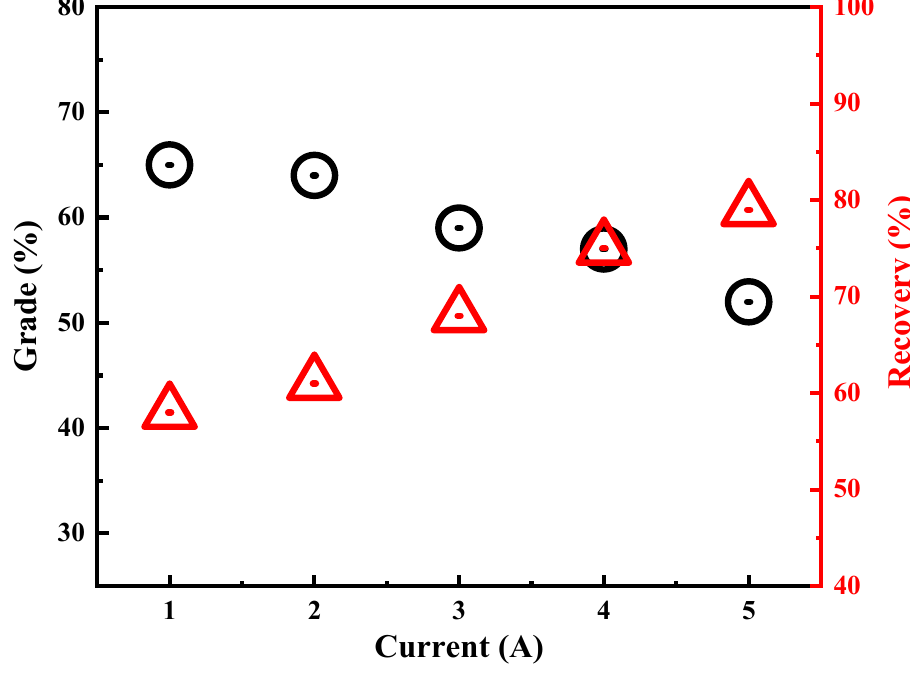
Figure 12. Current, grade, and recovery relationship of final beneficiated ore.